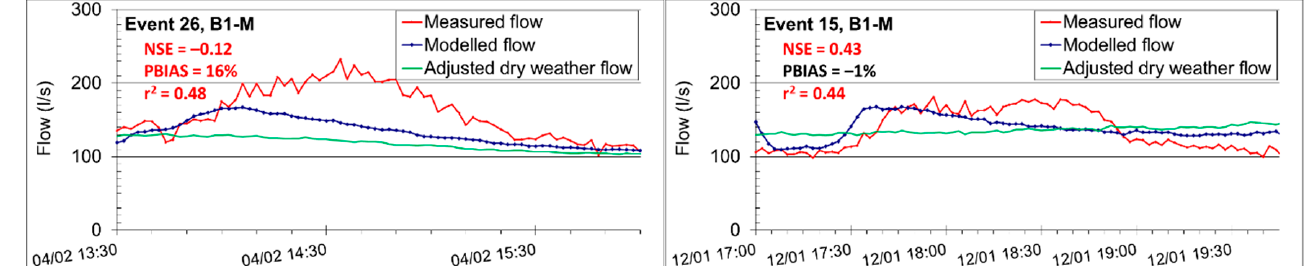
Figure 10. Measured and simulated hydrographs of the two events with the worst metrics.